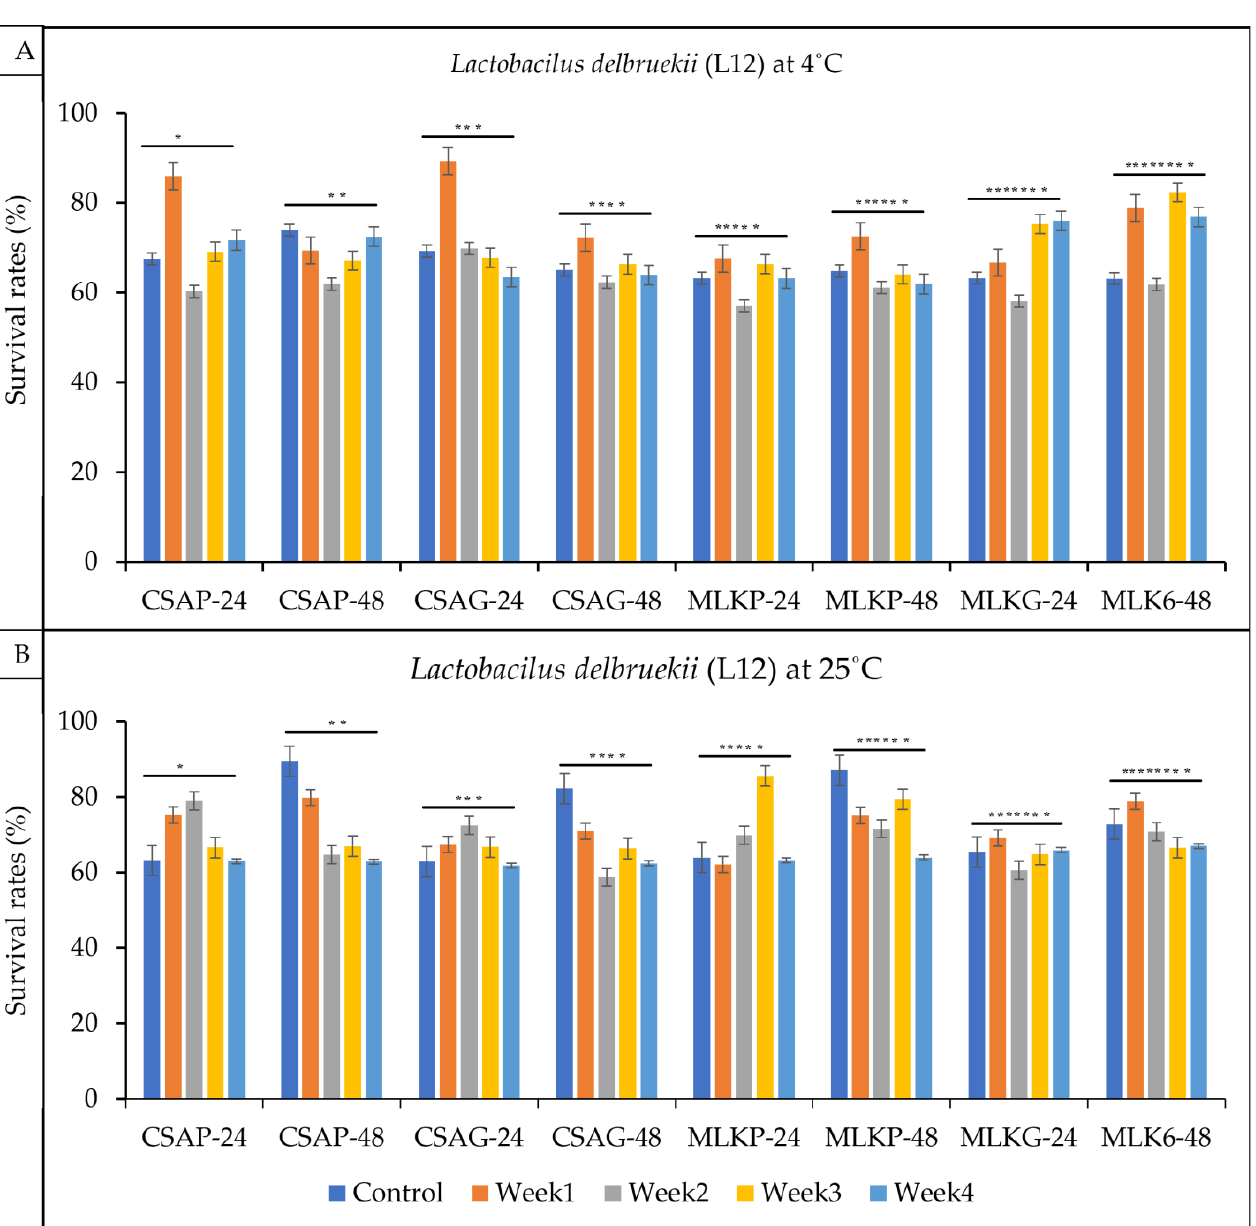
Figure 3. Viability of Lactobacillus delbrueckii (L12) following freeze-drying. ( A ) Survival rates at ambient temperature (25 ◦ C), and ( B ) survival rates at refrigerated temperature (4 ◦ C) for 24 h and 48 h. CSAP-24-Cassava in plastic at 24 h, CSAP-48-Cassava in plastic at 48 h, CSAG-24-Cassava in glass at 24 h, CSAG-48-Cassava in glass at 48 h, MLKp-24-Milk in plastic at 24 h, MLKP-48-Milk in plastic at 48 h, MLKG-24-Milk in glass at 24 h, MLKG-48-Milk in glass at 48 h. (Values represent means of three replicate experiments, ± : standard deviation). For ( A ) * p -value = 0.12298, ** p -value = 0.00031, *** p -value = 0.26069, **** p -value = 0.22889, ***** p -value = 0.46894, ****** p -value = 0.43324, ******* p -value = 0.02103, ******** p -value = 0.00023. For ( B ) * p -value = 0.00076, ** p -value = 0.000001, *** p -value = 0.00436, **** p -value = 0.0000001, ***** p -value = 0.02743, ****** p -value = 0.00001, ******* p -value = 0.31043, ******** p -value =